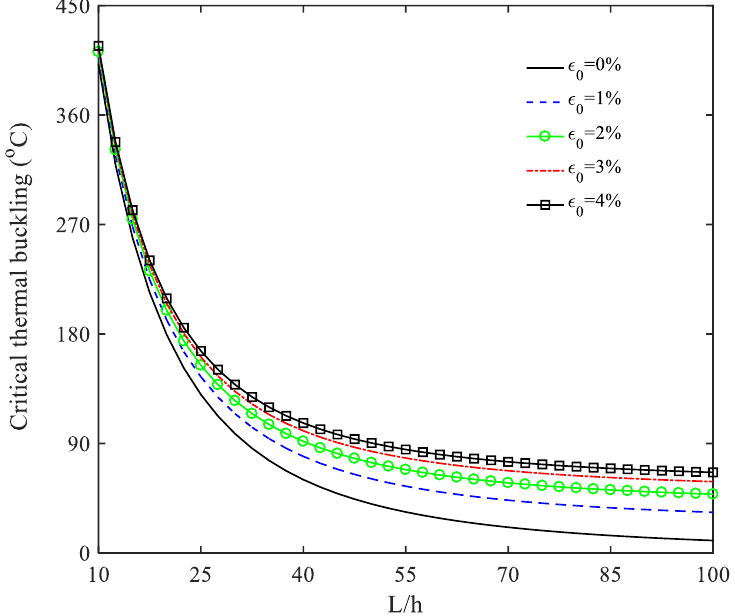
Figure 7. Variation of the critical thermal buckling vs. L / h for a linear distribution and different values of ε 0 ( n = 1, h c / h = 0.8 and V SMA = 0.2 ) .